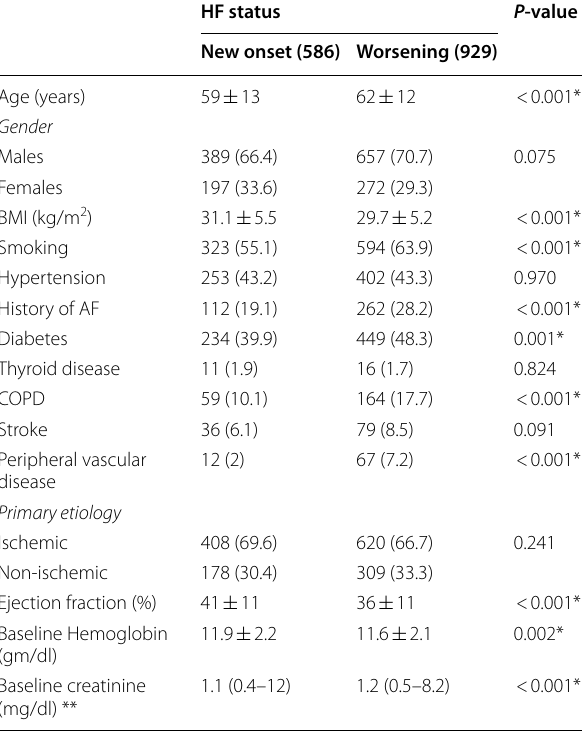
Table 2 General characteristics according to heart failure status